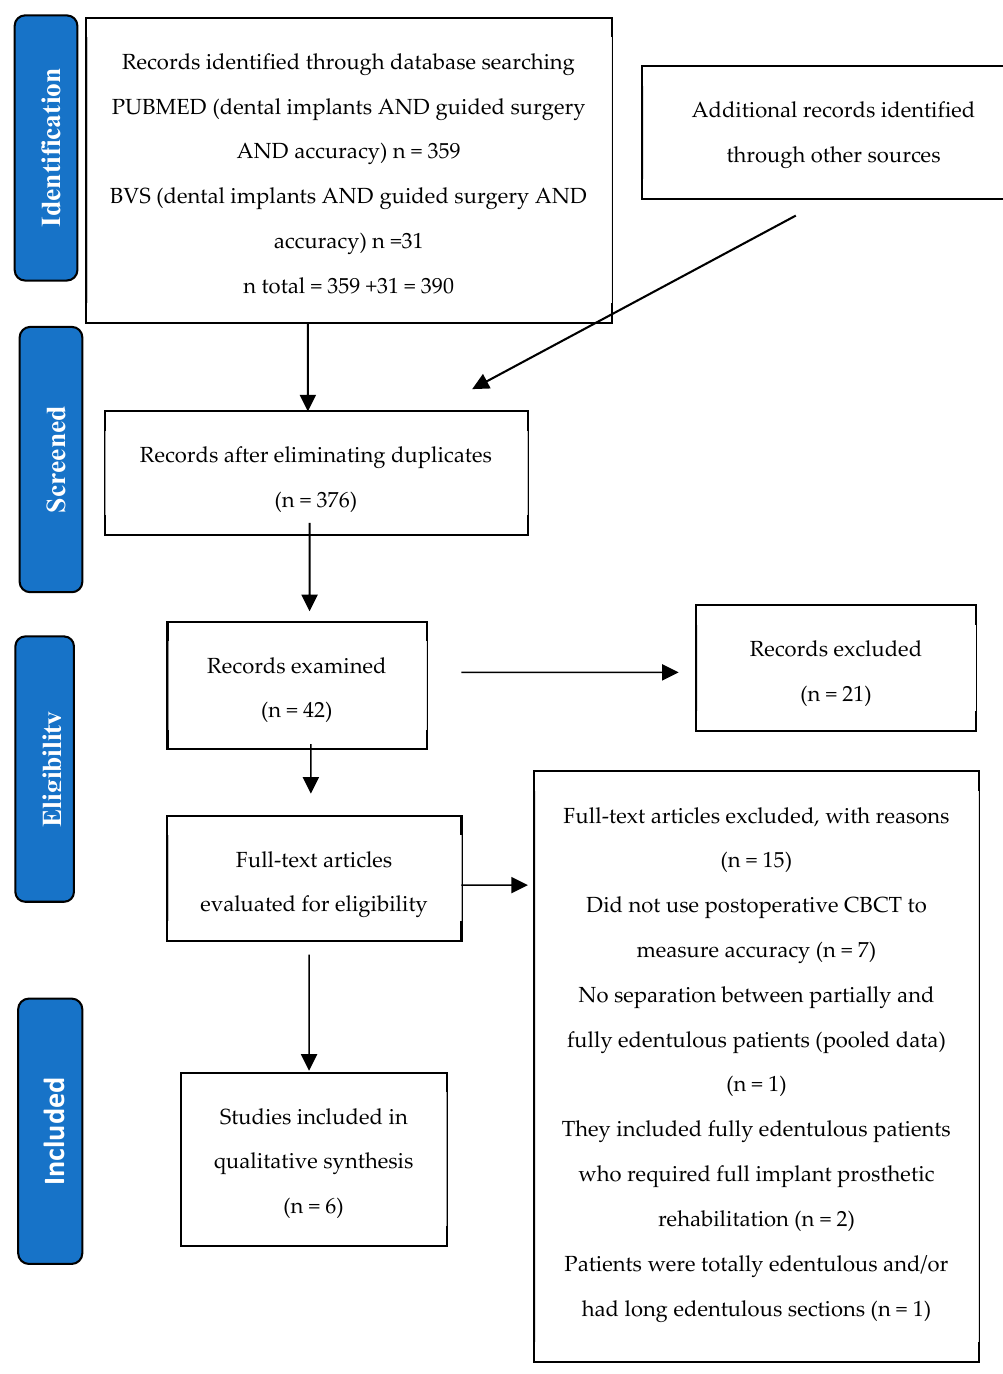
Figure 1. Flow chart of included studies according to PRISMA guidelines [16].